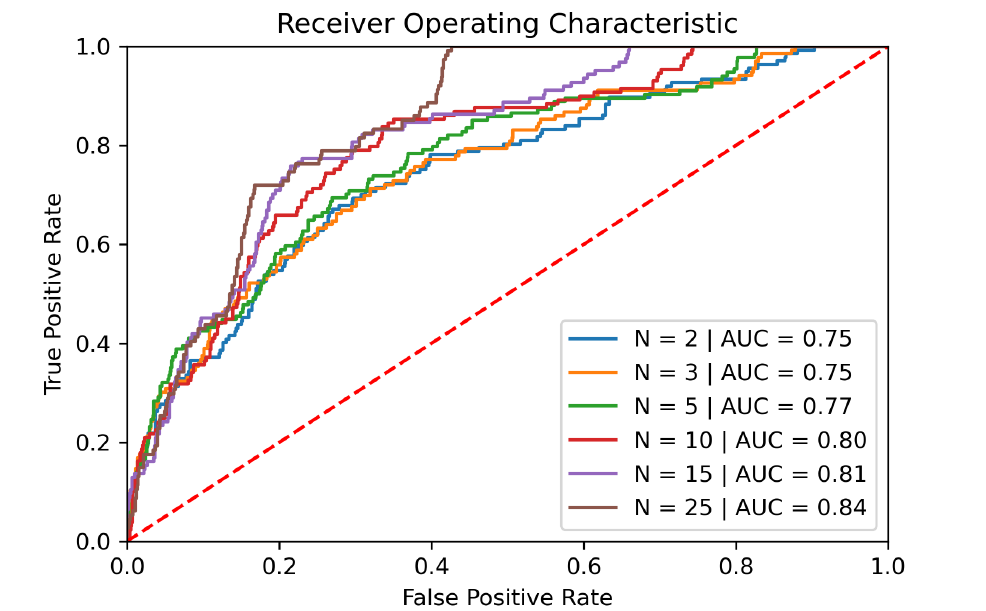
Figure 5. ROC multiple gestures for position data with gesture lengths bigger than 50—3 hidden states and 2